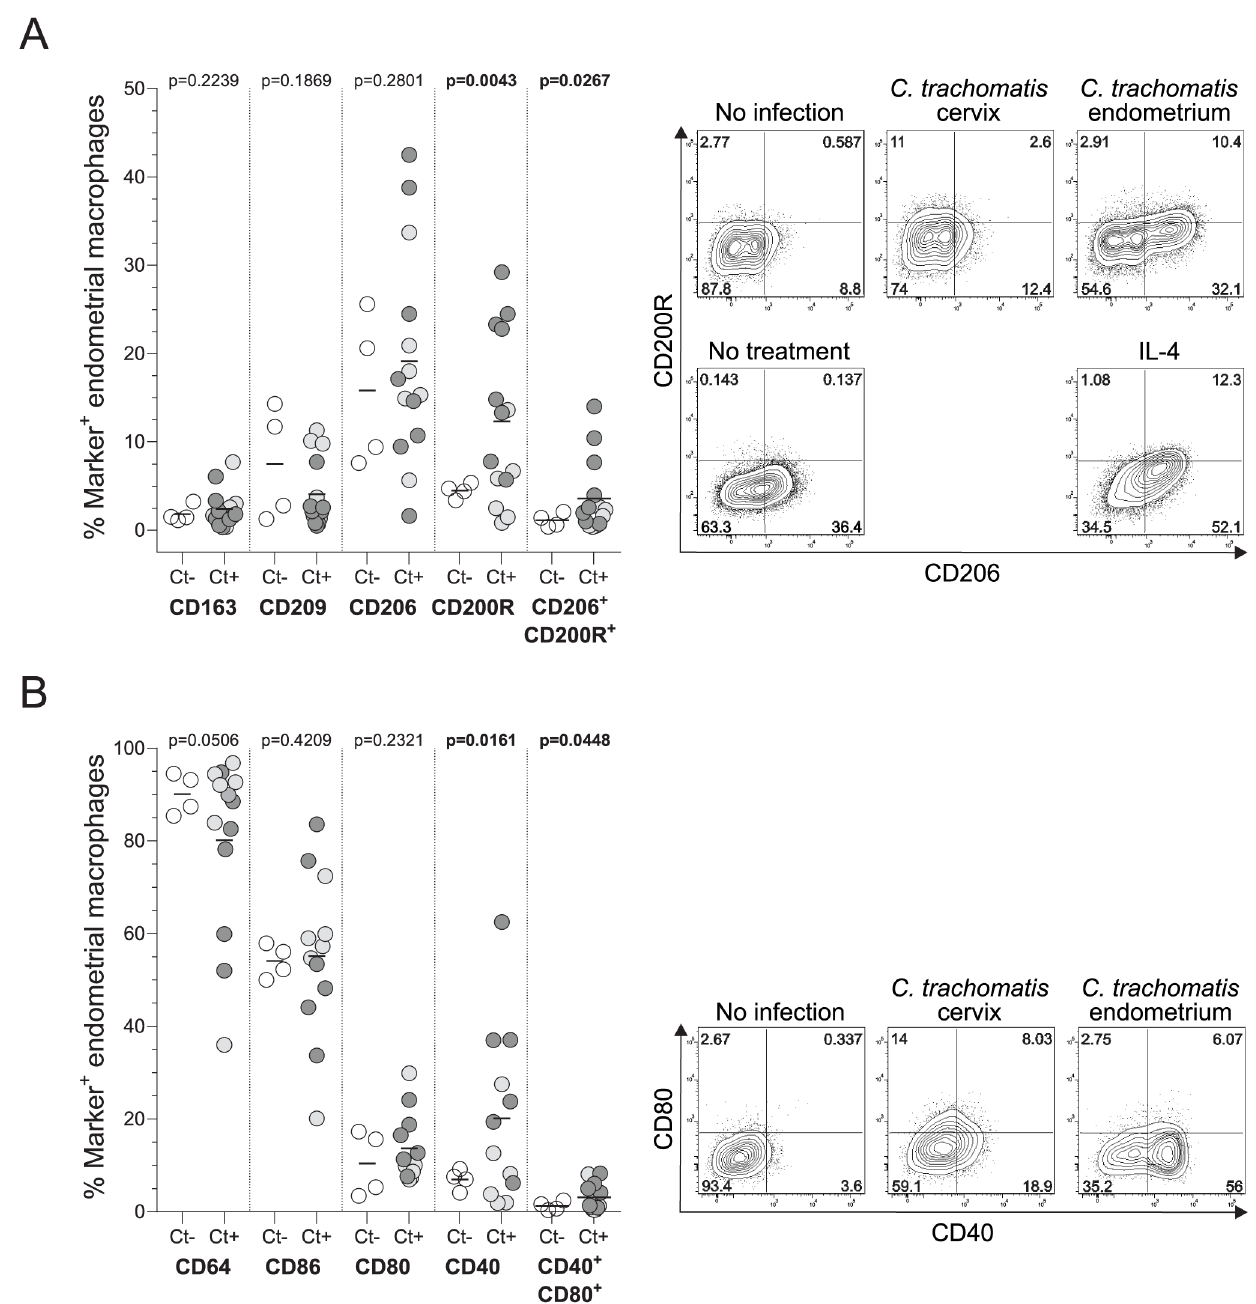
Figure 6. Endometrial Chlamydia infection promotes alternative activation of macrophages. Endometrial tissue from women with no identified C. trachomatis , N. gonorrhoeae , or T. vaginalis lower or upper genital tract infection (n=4), or from women with endocervical or endometrial C. trachomatis infection (n=14 for Panel A; n=12 for Panel B) were processed for flow cytometric analysis as described in Methods section. Macrophages were identified as FSC-A int SSC-A int CD45 + CD15 - CD14 + HLA-DR + live cells (as depicted in Figure S3), and 2 monoclonal antibody panels were used to interrogate macrophage differentiation and activation. Panel (A) evaluated expression of CD163, CD209, CD200R and CD206, while panel (B) evaluated expression of CD64, CD80, CD40 and CD86. Comparisons were done using unpaired one-tailed Student t-tests with Welch’s correction (horizontal bars indicate mean values for each group and significant p values are indicated in bold characters). Open circles indicate samples from uninfected controls; light gray circles indicate samples from women with cervical Chlamydia infection; and dark gray circles indicate samples from women with endometrial Chlamydia infection. Representative contour plots of CD200R, CD206, CD40 and CD80 expression by endometrial macrophages are displayed next to figures. For CD200R and CD206 expression evaluation (A), representative flow plots from peripheral blood monocytes treated with IL-4 (100 U/ml) for 24 hours and the corresponding untreated control are also shown.